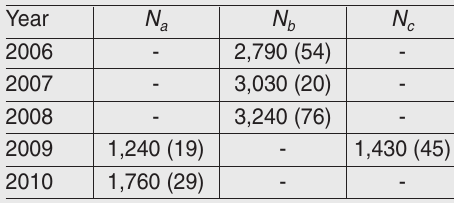
Table 1. Abundance estimates with cv in paren- thesis (given in %). N a is spring estimates from the North Water (Baffin Bay population). N b is estimates for West Greenland/Baffin Island. N c is a 2009 estimate for East Greenland. Data from Born et al. (2009), Heide-Jørgensen et al. (2009b), Stewart et al. (2009b), and Heide- Jørgensen et al.